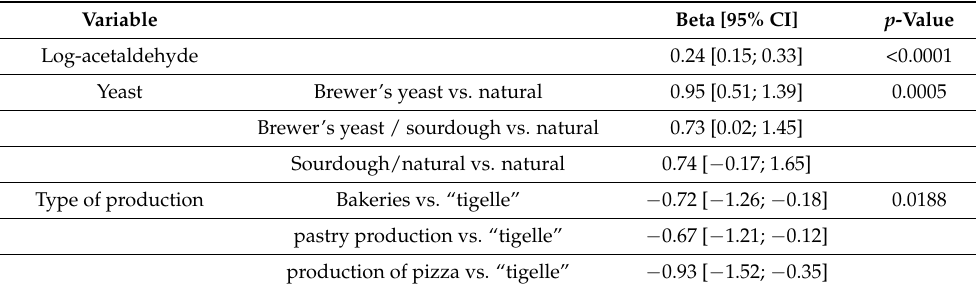
Table 4. Adjusted (log-acetaldehyde) multivariable model considering log-formaldehyde as outcome. Beta and 95% confidence interval were